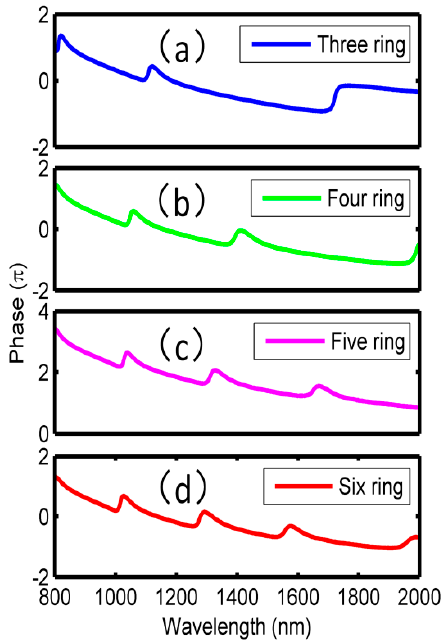
Figure 6. Phase responses of multiring resonators. ( a ) Three rings; ( b ) four rings; ( c ) five rings; and ( d ) six rings.